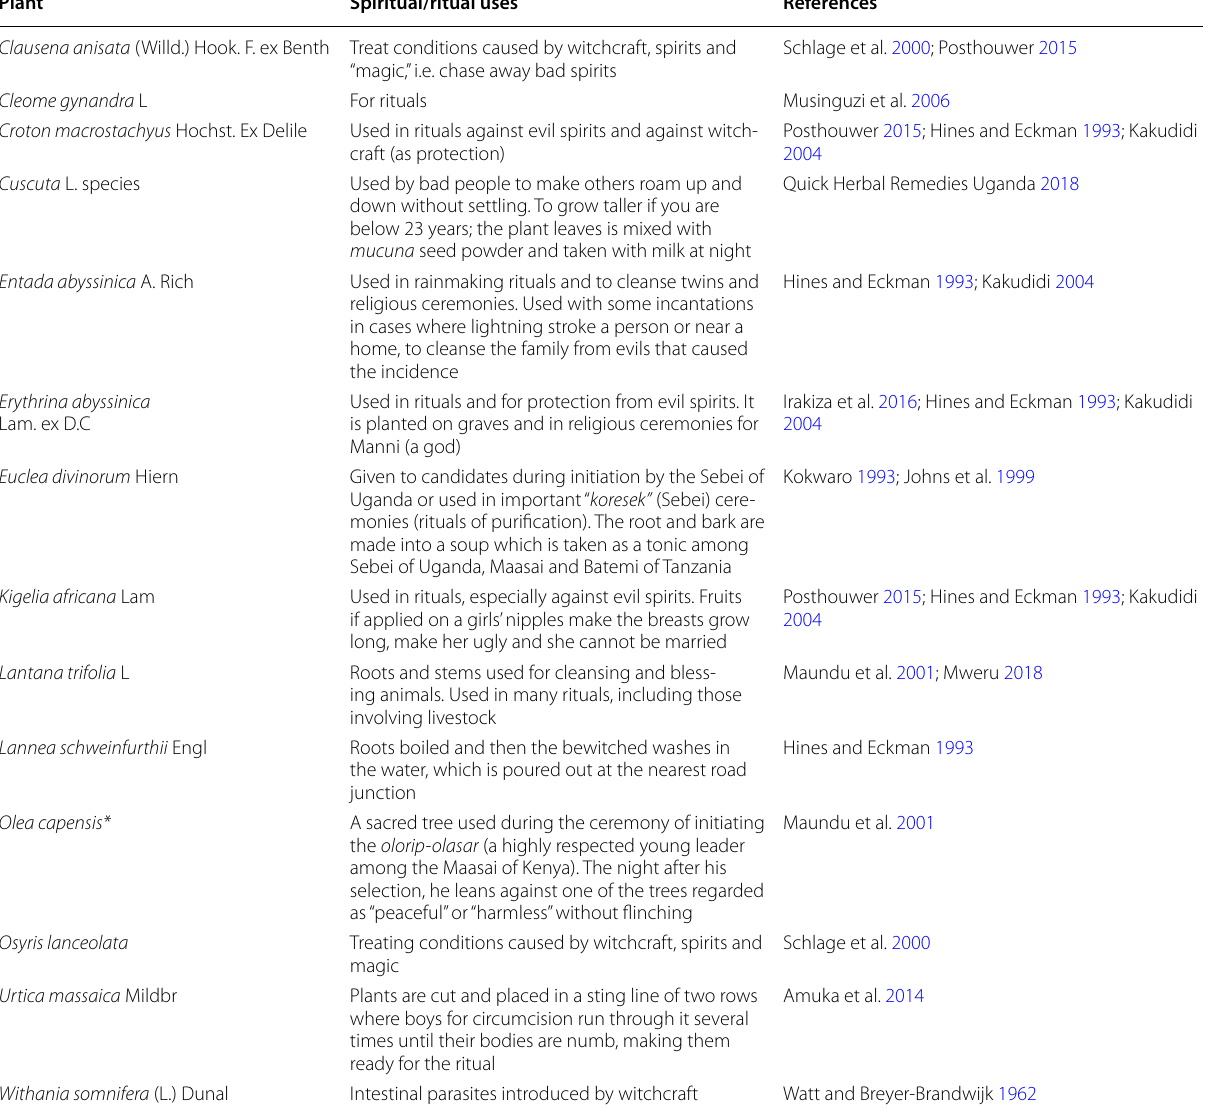
* Used with those of Olea europaea subspecies africana , Podocarpus species and a fig ( Ficus thonningii )